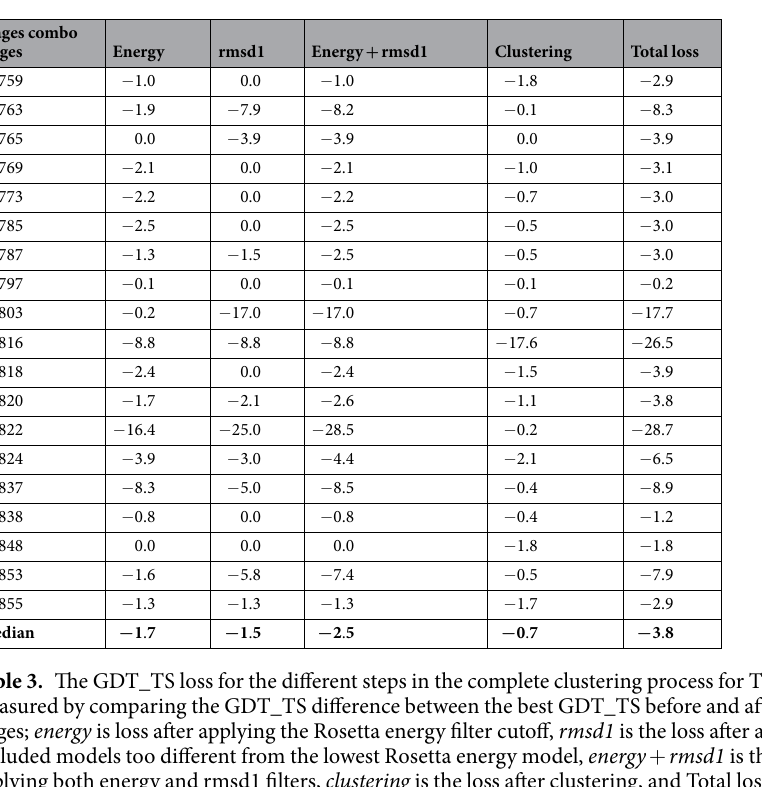
improvement or deterioration measured by the best GDT_HA for each step of the pipelines and for each target. GDT_HA is the High Accuracy GDT defined as GDT_HA = ( GDT_P0 . 5 + GDT_P1 + GDT_P2 + GDT_P4 )/ 4 , where GDT_Pn denotes percent of residues under distance cutoff <= n Å. This figure shows that in the first